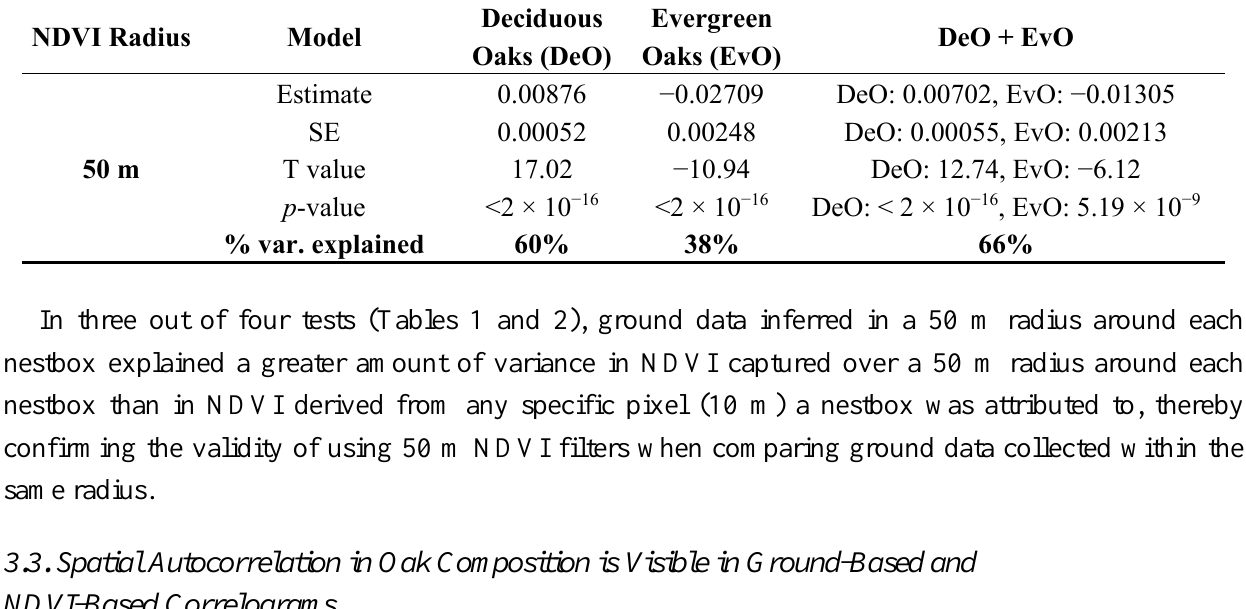
Table 3. Effect of the number of deciduous oaks (DeO), evergreen Oaks (EvO) and DeO + EvO on pixel-based NDVI in a 50 m radius around the nestbox using NDVI amplitude data (average of three latest NDVI values—three earliest NDVI values).